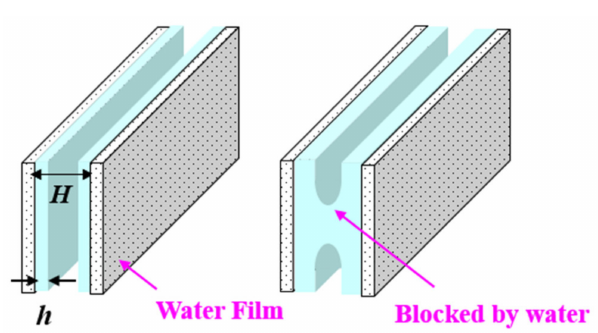
Figure 12. Effect of bound water on gas transport in slit